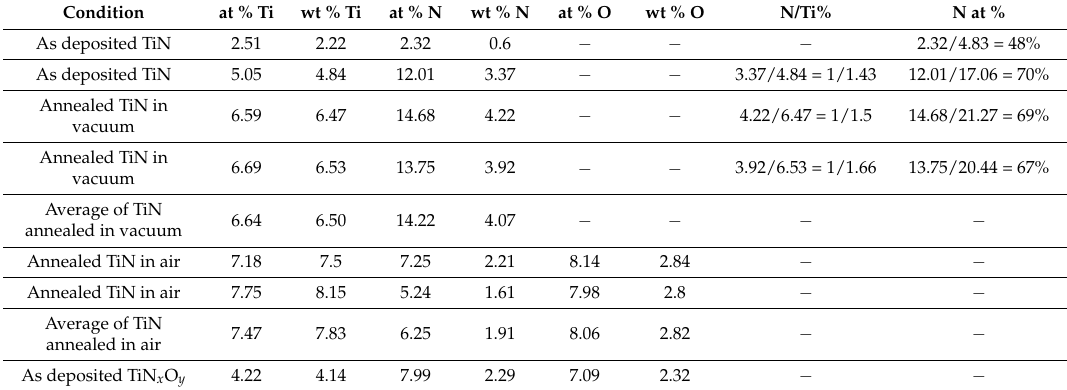
Table 1. Composition of TiN, TiN x O y , and annealed TiN at 400 ◦ C in air and in vacuum thin films